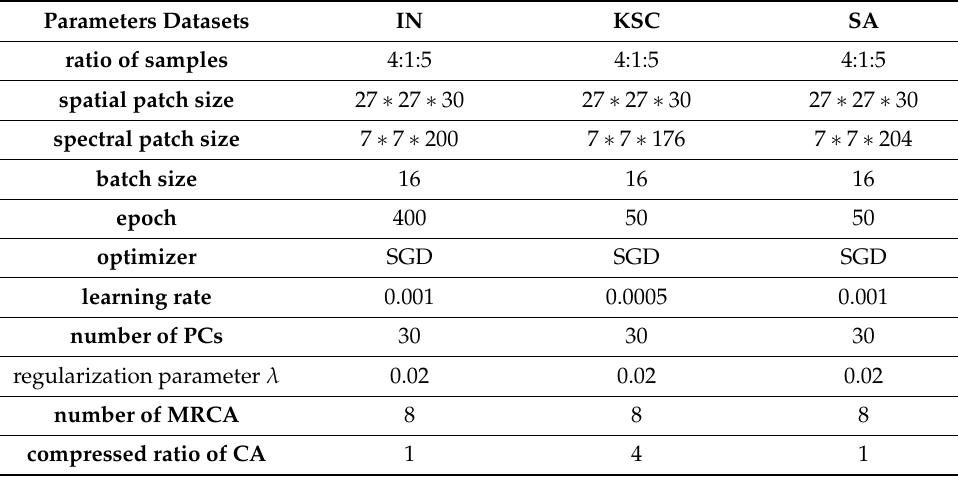
Table 4. The network parameter setting of the proposed